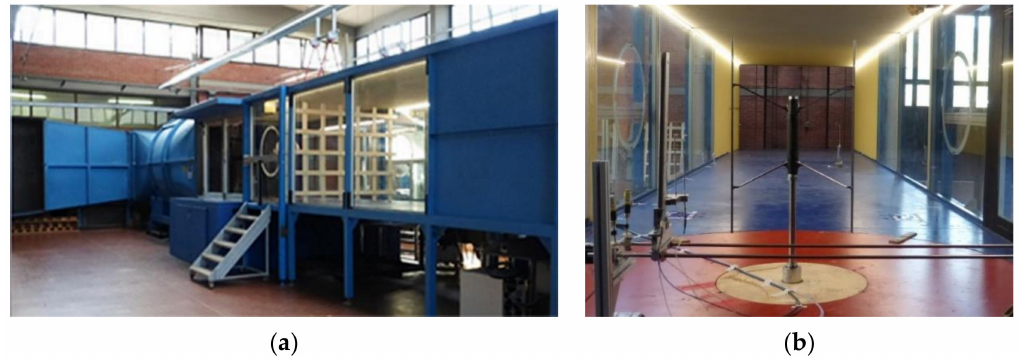
Figure 4. ( a ) Wind tunnel with a wooden grid for turbulence generation installed; ( b ) analyzed wind turbine.